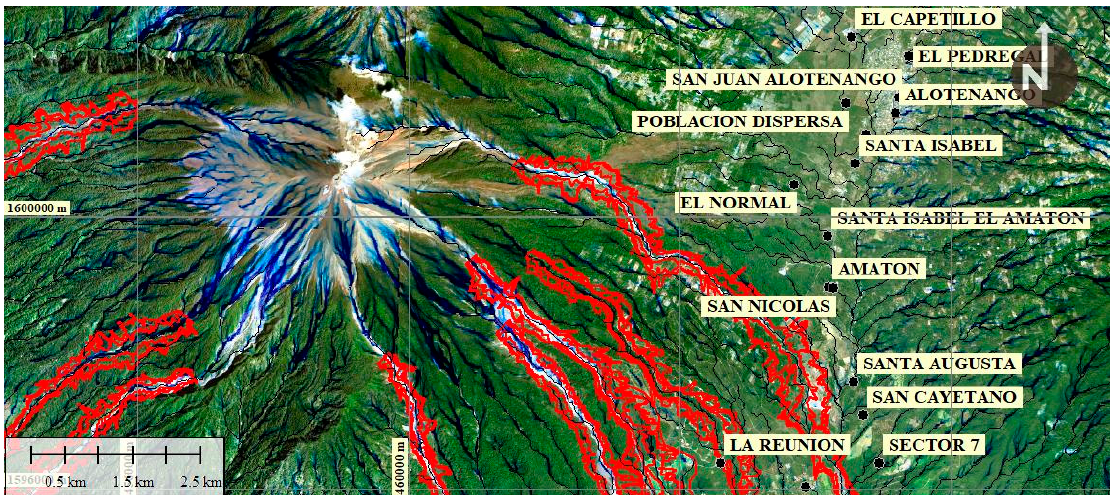
Figure 3. LAHAR Z Model (red lines) and the poor tracing of possible secondary lahars and analysis of their distal trajectories originating from proximal sources. The morphometric model combines parameters such as the flow accumulation (FCC), the topographical humidity index (TWI), and slope-length factor of the slope to more accurately determine the trajectories of the destructive lahars.